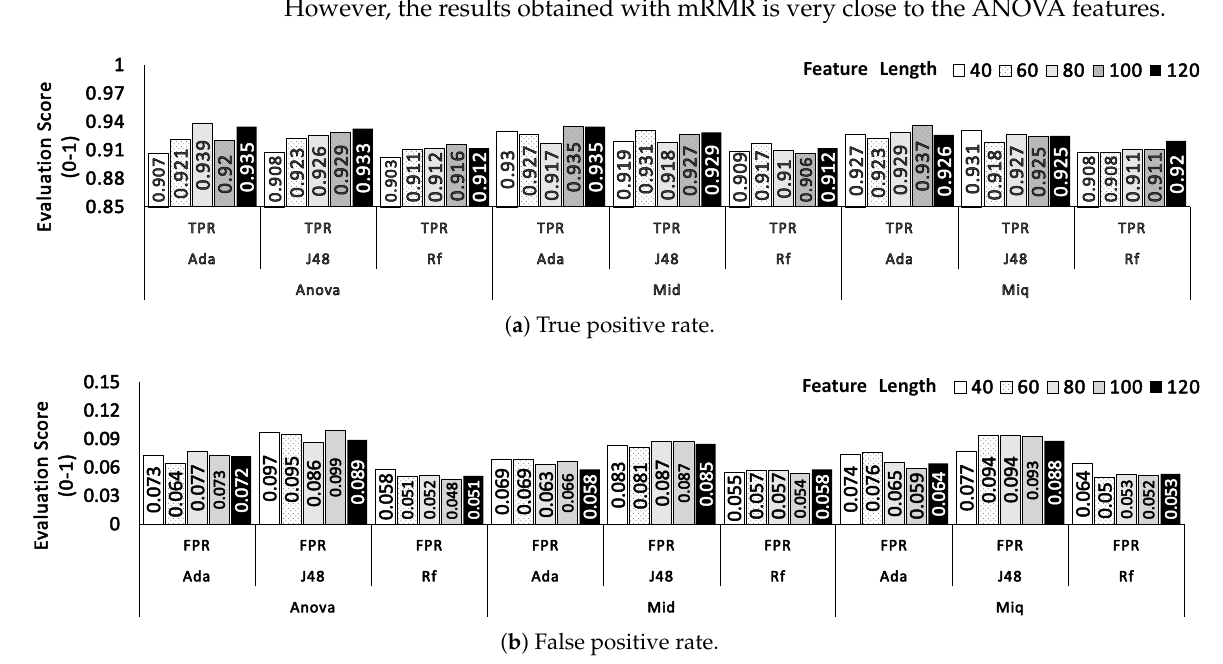
Figure 7. Performance of classifier trained on opcode